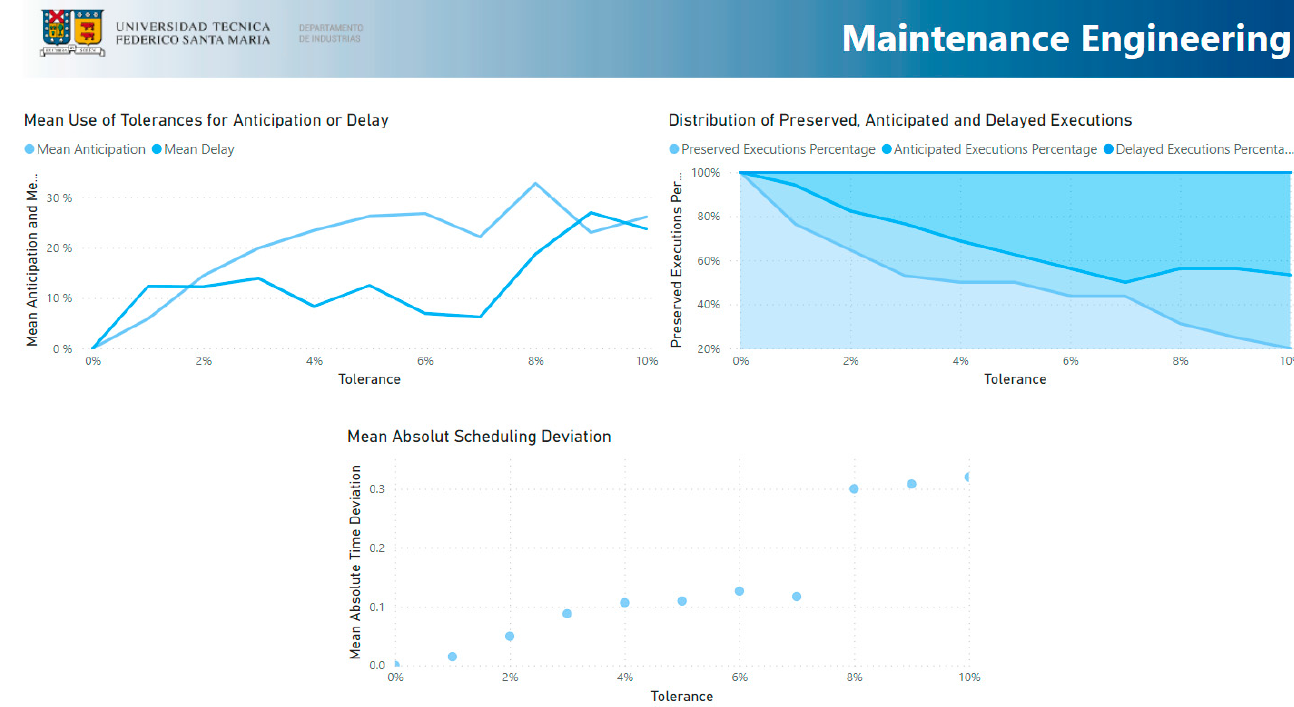
Figure 7. Maintenance engineering.